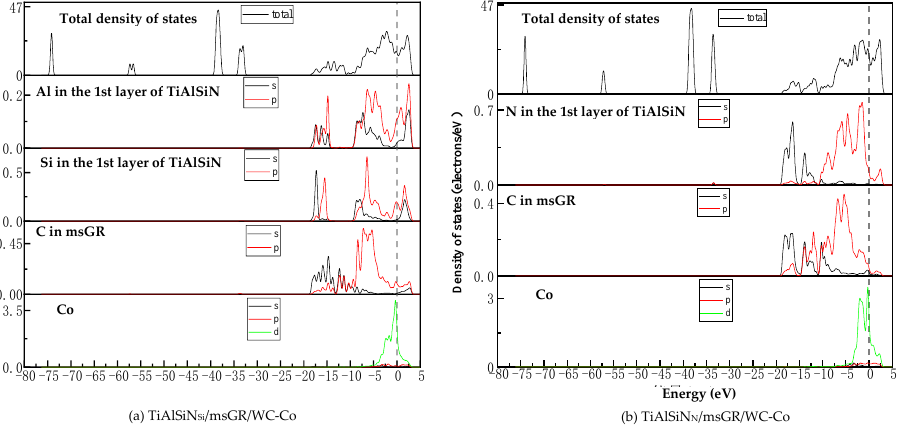
Figure 20. PDOS of the interface models with the coating doped with defective graphene.